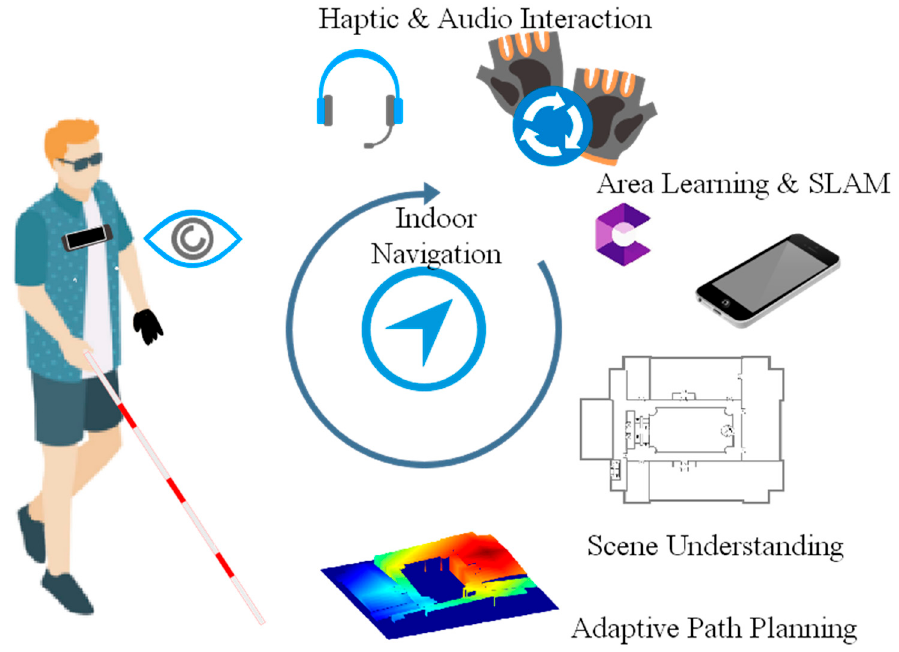
Figure 1. The components of the proposed ANSVIP system.